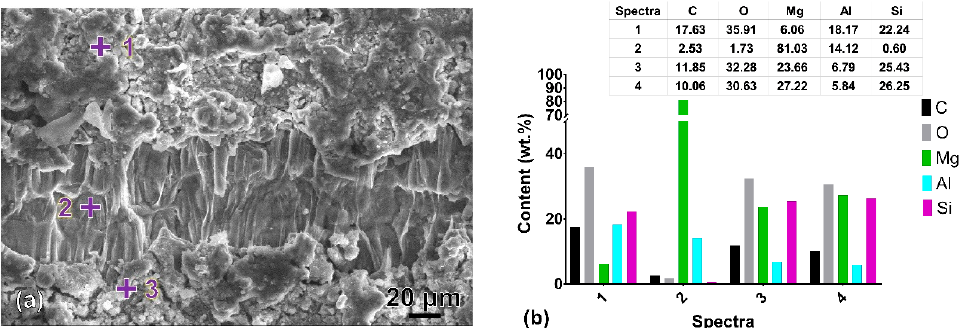
Figure 12. ( a ) Enlarged view of the rectangular area in Figure 11a and the ( b ) elemental analyses for the spectra numbered 1 to 3.